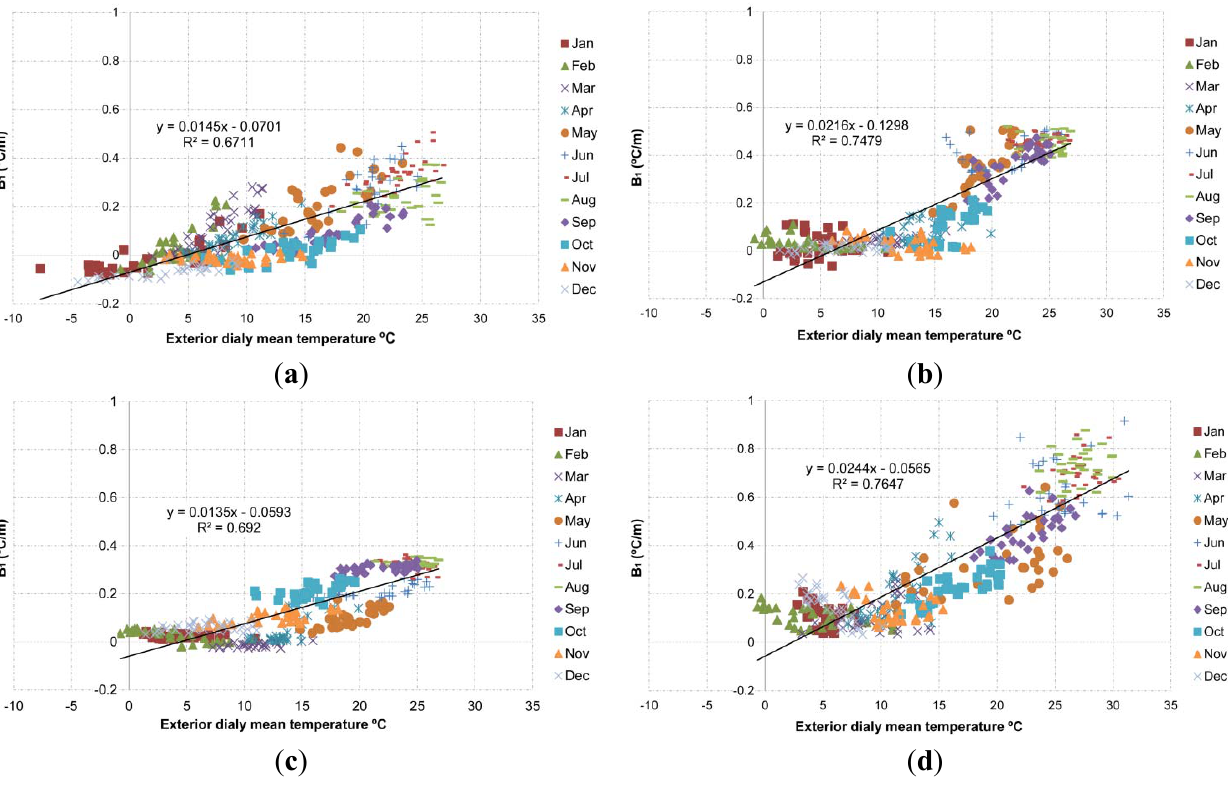
Figure 4. Relationship between the stratification of the indoor air, measured through the coefficients β , and the temperature of outdoor air. Average daily values: ( a ) 1